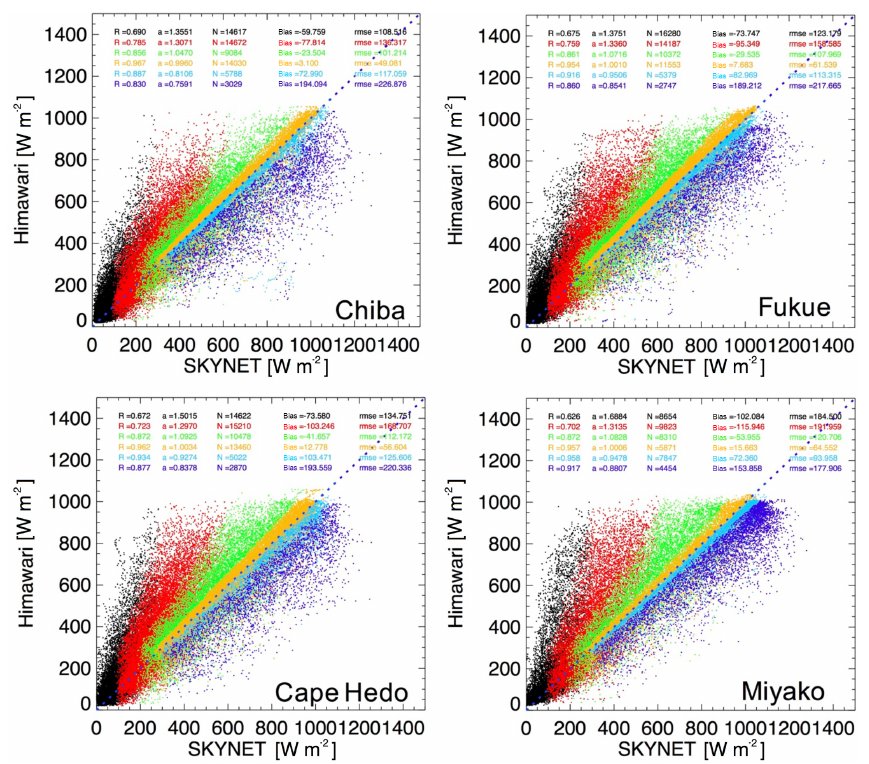
Figure 7. Scatter plot of surface global irradiance data obtained by ground-based SKYNET observations and Himawari-8 estimates at the four SKYNET stations. Colors indicate different clear-sky index ranges (based on SKYNET observations): black (0–0.3), red (0.3–0.6), green (0.6–0.9), orange (0.9–1), light blue (1–1.1), and violet (RE events). Statistics describing the comparison, i.e., correlation coefficient ( R ), slope of the regression line (a) , number of samples ( N ), mean bias (bias), and root mean square error (RMSE), are shown; the dashed line is a 1:1 line. Time step: 2.5min. See text for further